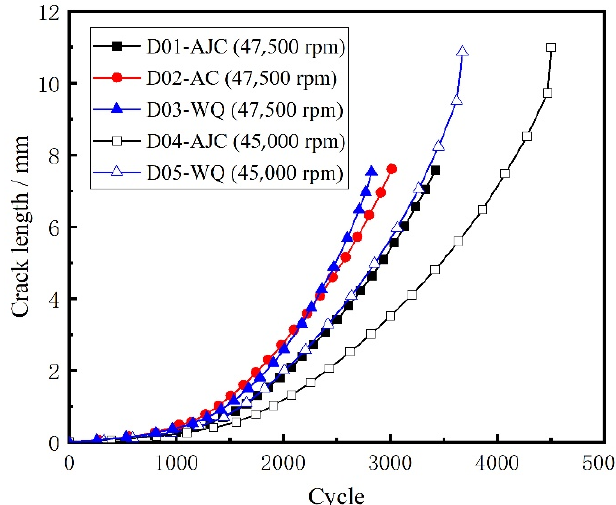
Figure 24. Crack length with cycle by using FRANC3D.